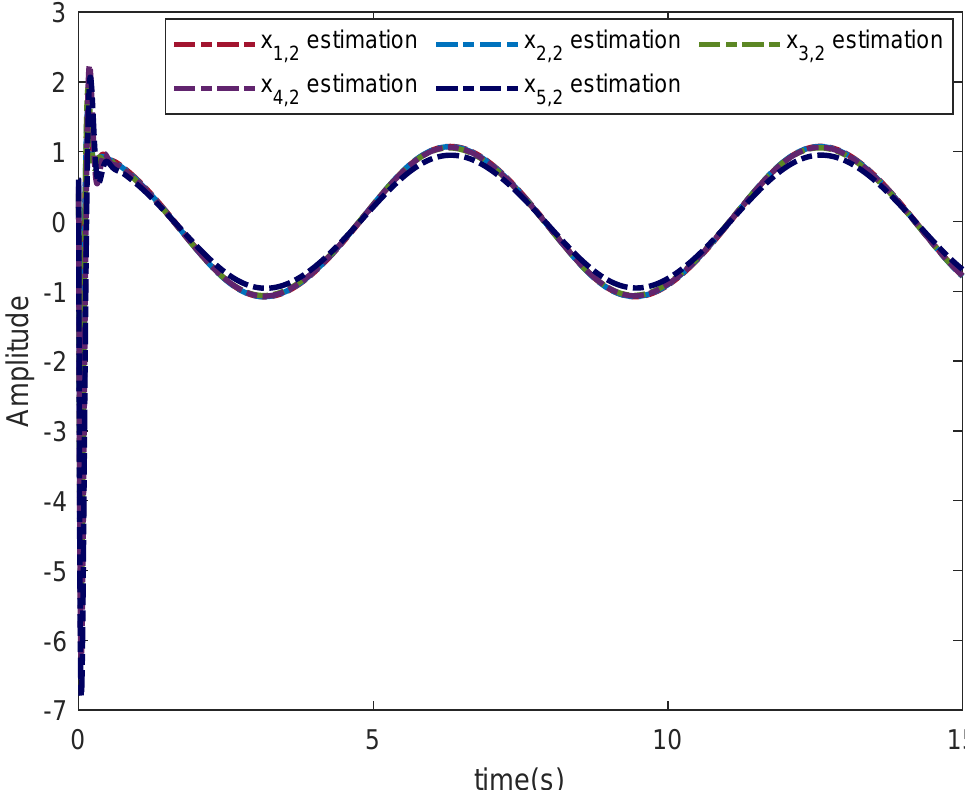
Figure 7. The trajectories of x i ,2 ( i = 1, · · · ,5 ) estimation